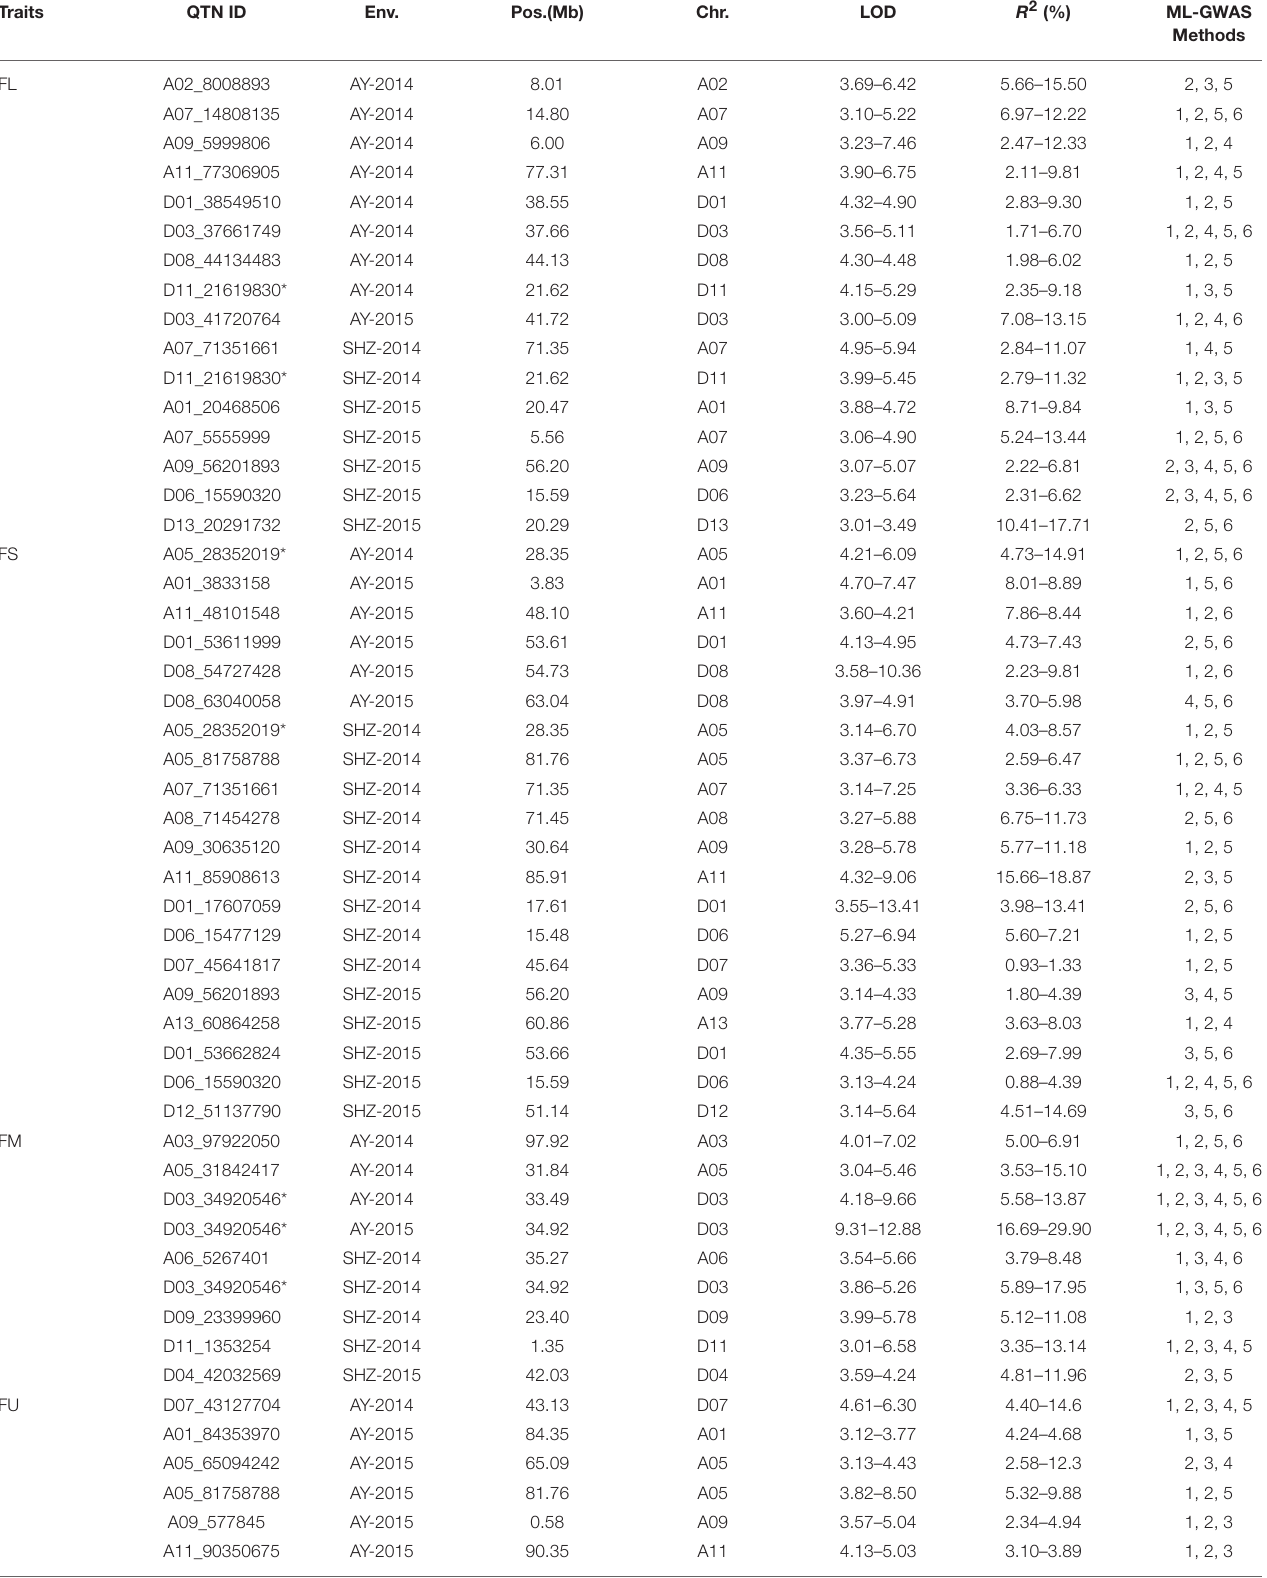
TABLE 3 | The significant QTNs for five fiber-quality related traits detected simultaneously by using three or more multi-locus GWAS methods. Traits QTN ID Env. Pos.(Mb) Chr. LOD R 2